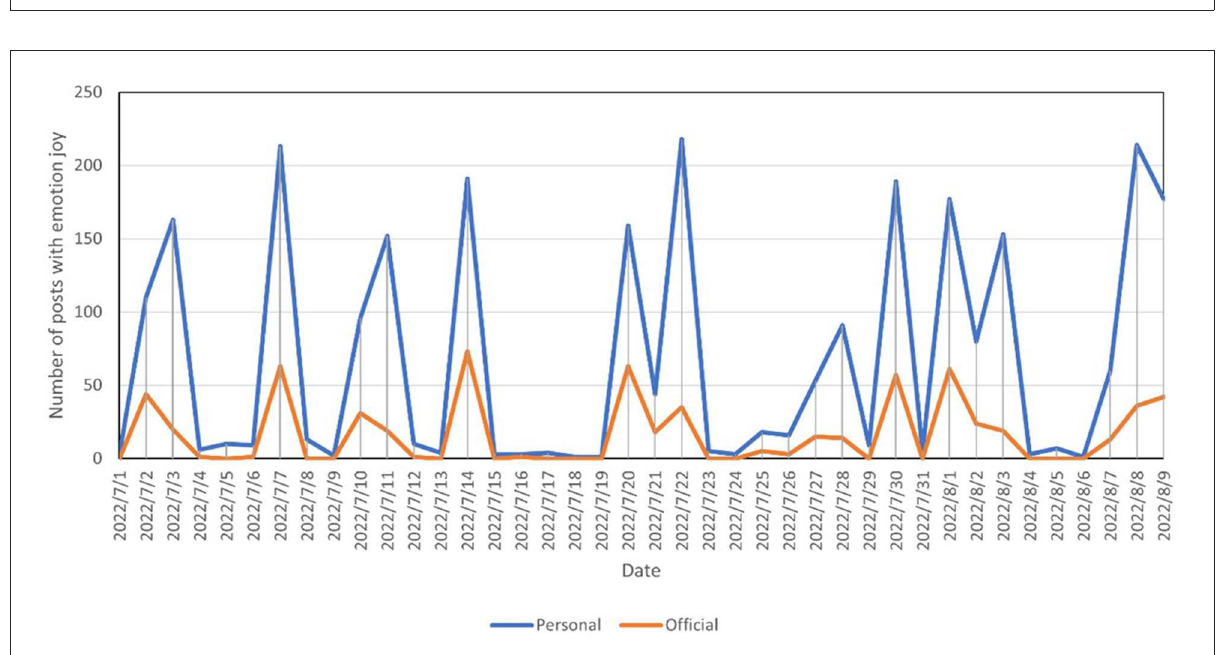
FIGURE3 Number of blogs with the emotion of joy posted by official and personal